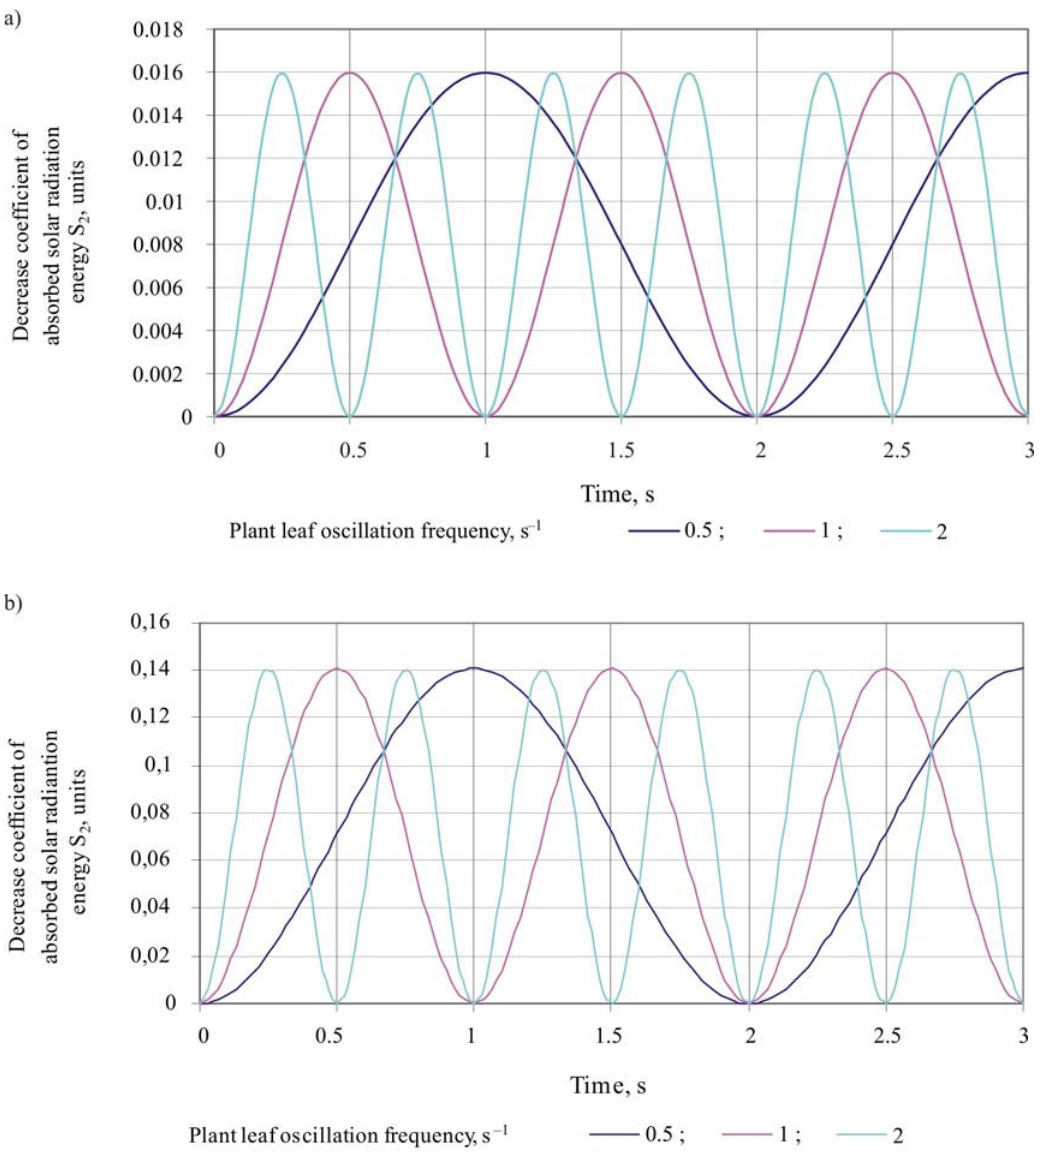
Fig. 5. Dependence of the decrease coefficient of the absorbed solar radiation energy S 2 on time during periodic change of the leaf position angle β when the plant leaf oscillation amplitudes: a − β A = 10 o , b − β A = 30